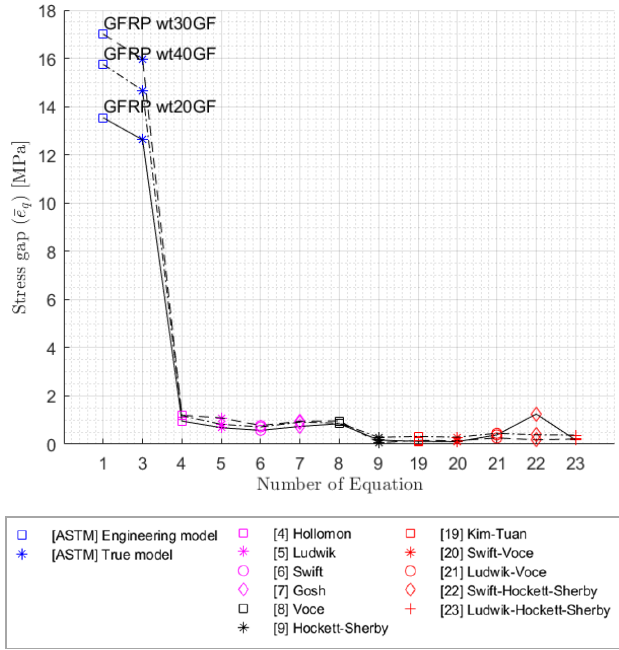
Figure 11. Error values of the optimized inverse method.